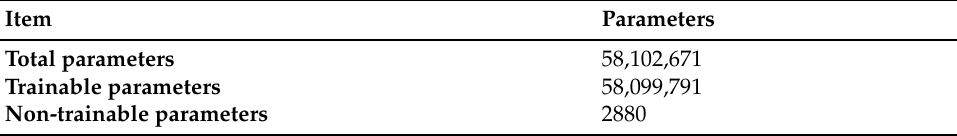
Table 4. CNN/VGG-19 network model